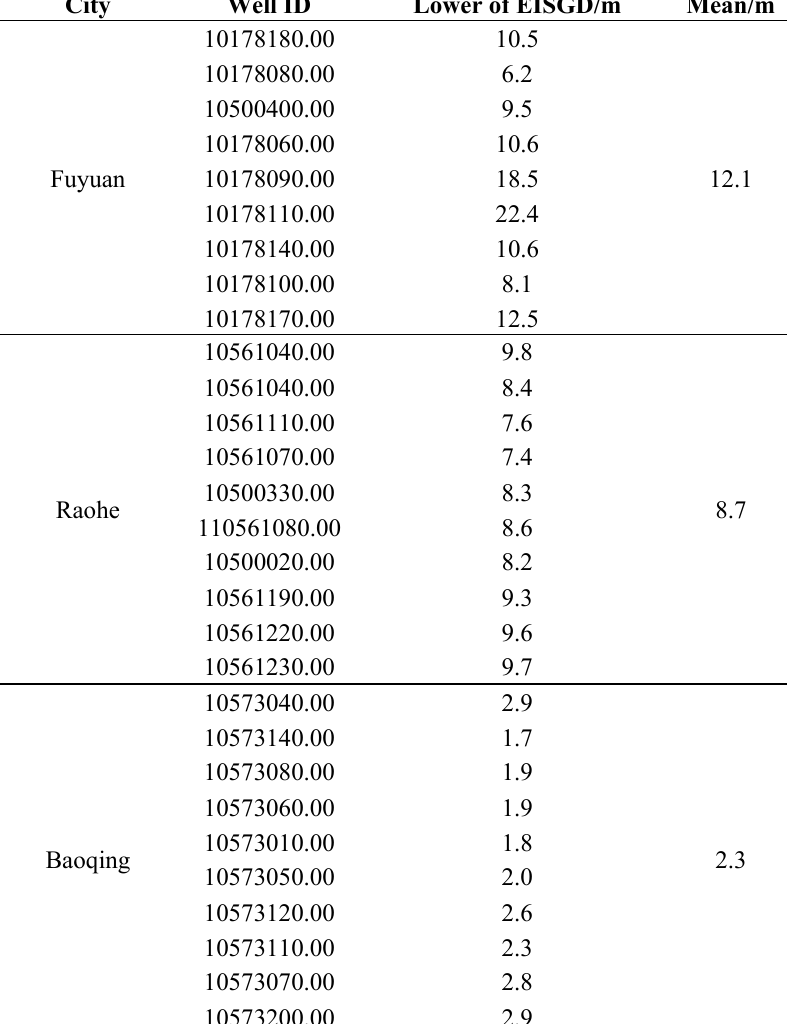
Table 2. The lower boundary of ecologically ideal shallow groundwater depth (EISGD) of the Sanjiang Plain in Northeast China. An EISGD lower boundary represents the hypothetical extinction depth of a certain vegetation cover (for further explanation, see Section